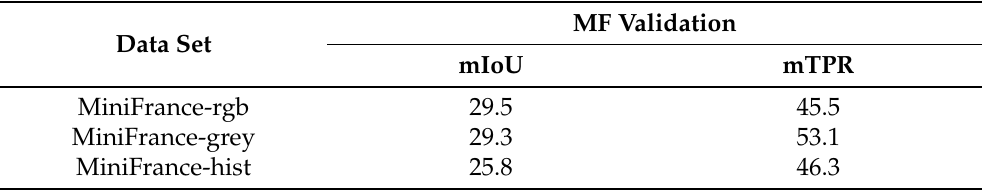
Table 5. Summary of semantic segmentation results using UNet-EffB5 on the MiniFrance (MF) validation set using RGB, greyscale or historical-like (CycleGAN translated)